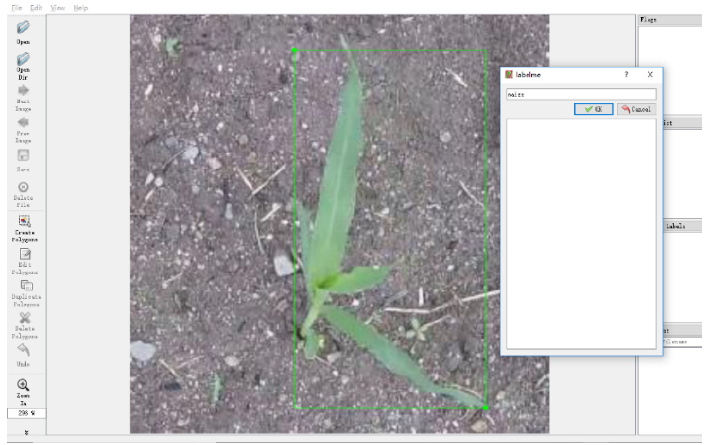
Figure 8. Annotation of maize plants.